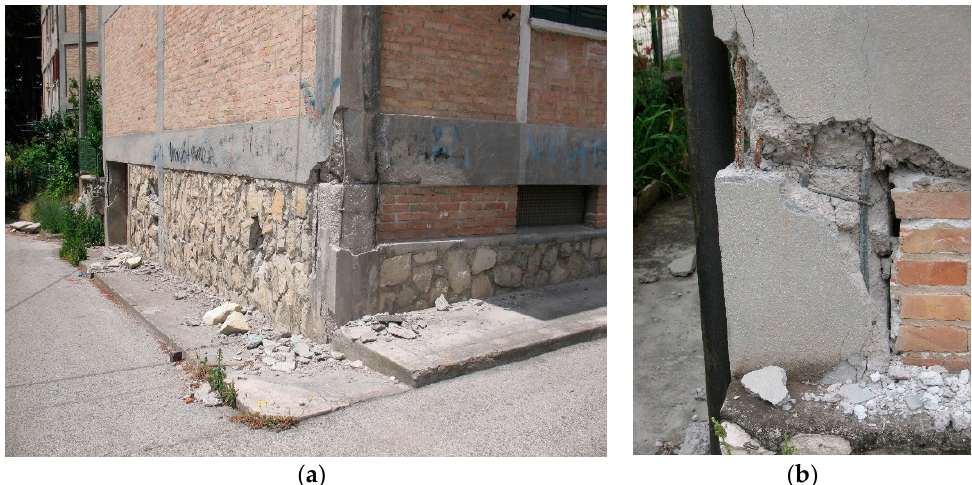
Figure 4. Interaction between infills and RC structural members. ( a ) Damage to column and joint, ( b ) detail.